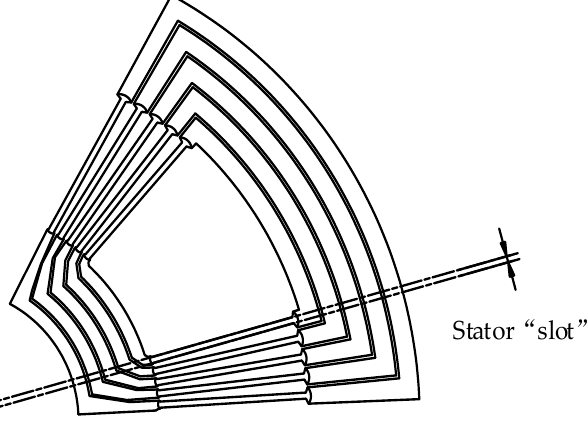
Figure 2. Structure diagram of an equivalent stator “slot”.